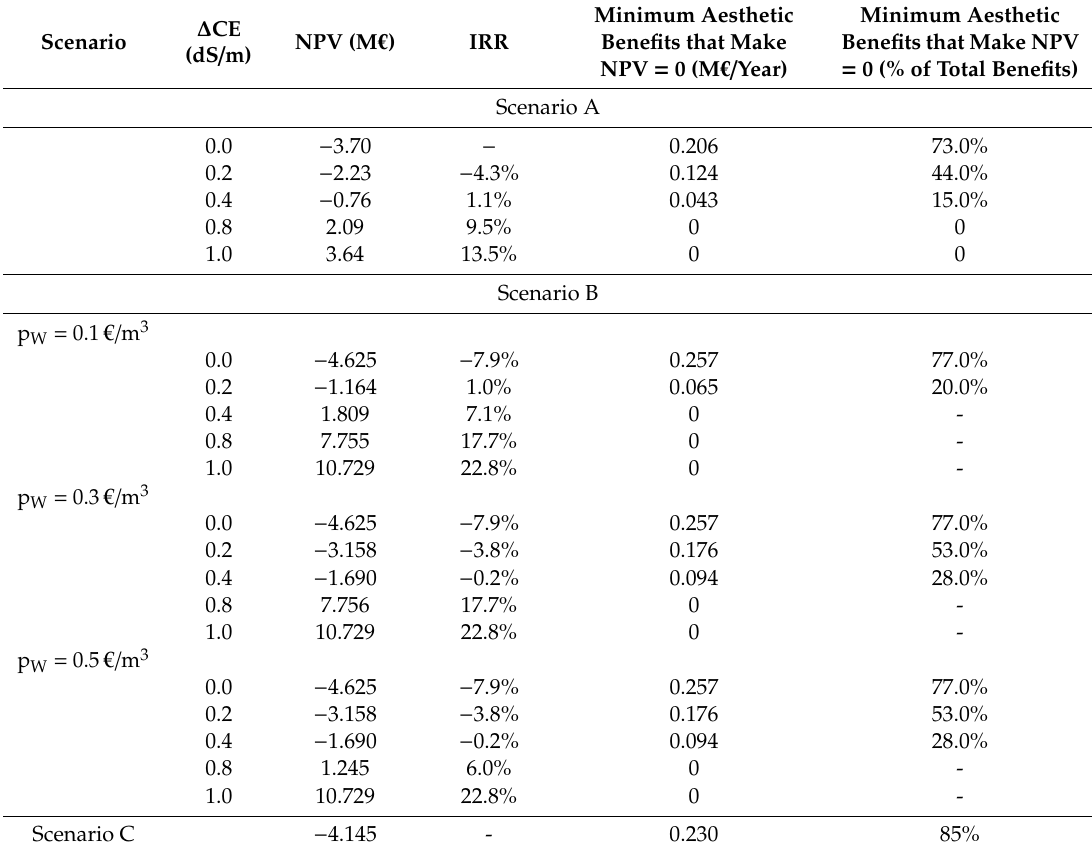
Table 7. Cost-Benefit Indicators (NPV and IRR) for the three scenarios described in the Results section and various. The table also contains the estimated minimum additional benefits necessary to make the project sustainable (NPV ≥